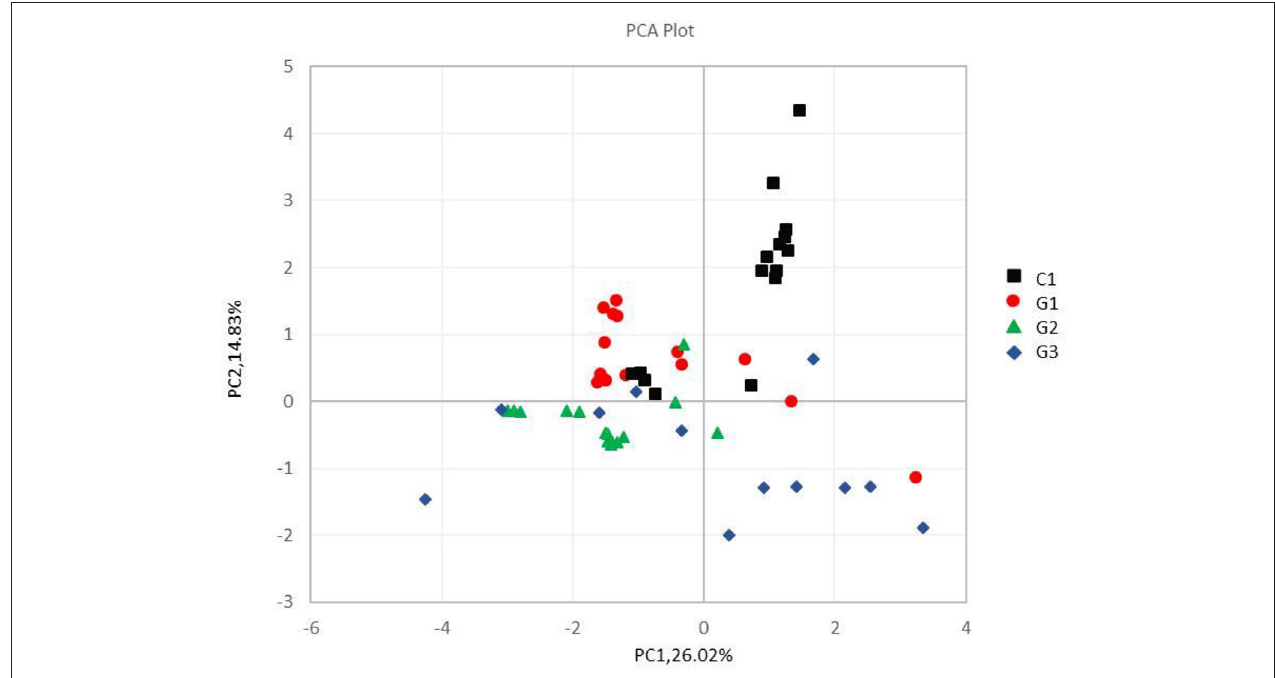
FIGURE 5 | Principal component analysis of different samples at the phylum level. The abscissa and the ordinate represent two principal components, respectively, and the percentage indicates the contribution of the principal component to the sample difference; the same group of samples is represented by the same color dot.